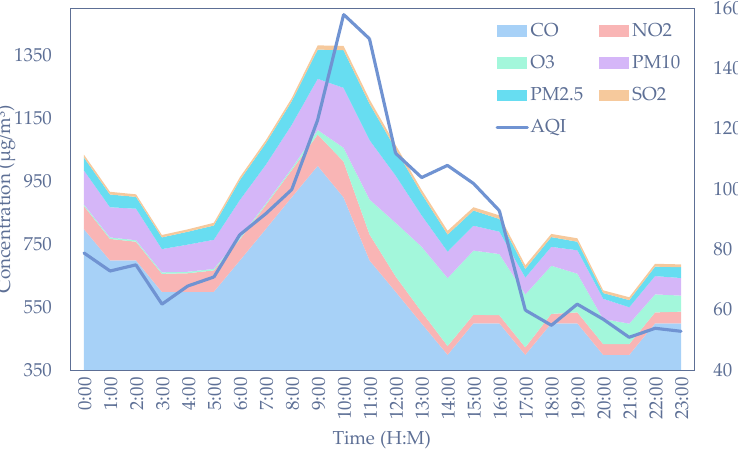
Figure 2. Concentration of pollutants and calculated AQI.